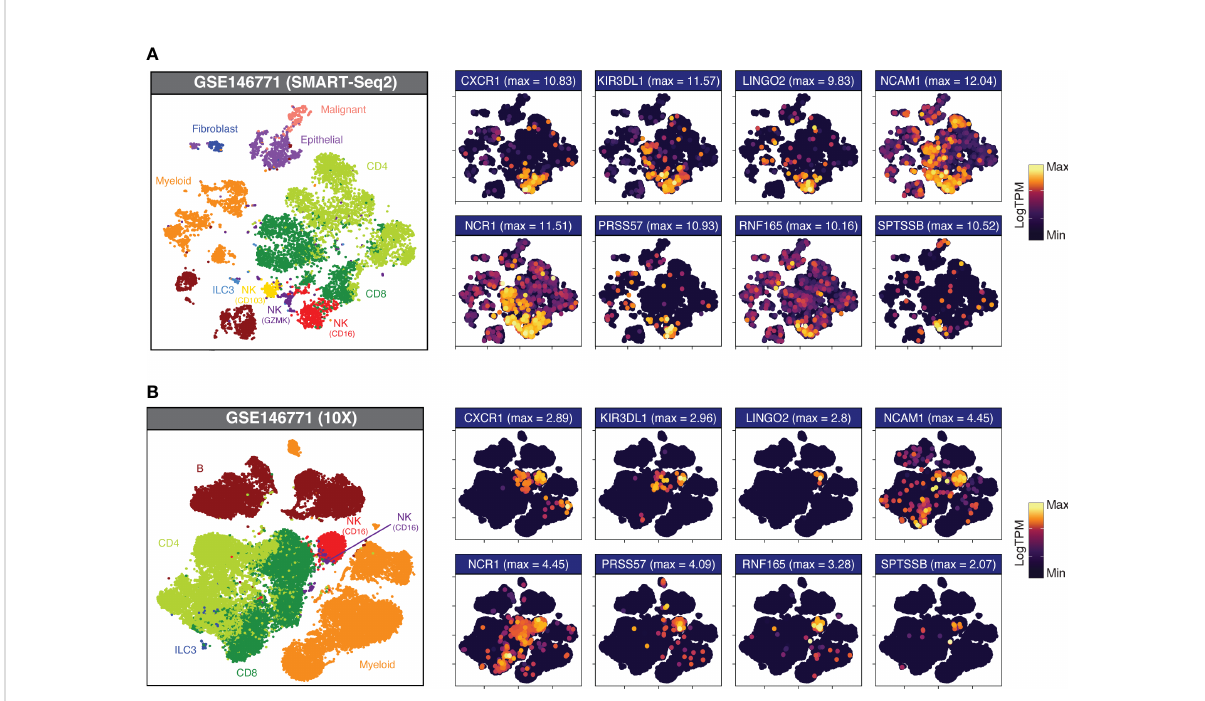
FIGURE 3 Candidate gene expression in CRC-in fi ltrating immune cells. UMAP plots of dissociated primary CRC samples from (A) GSE146771 (SMART-Seq2 scRNAseq; n samples = 10) and (B) GSE146771 (10X scRNAseq; n samples = 10) coloured by cell type (at left) and candidate gene expression. Maximum expression (LogTPM) is indicated in parentheses above each